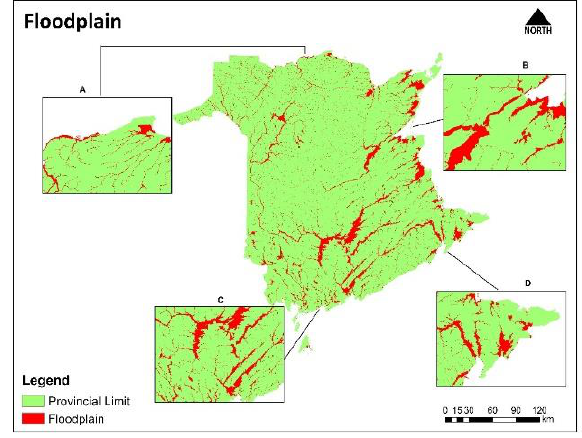
Geosciences 2020 , 10 , x FOR PEER REVIEW